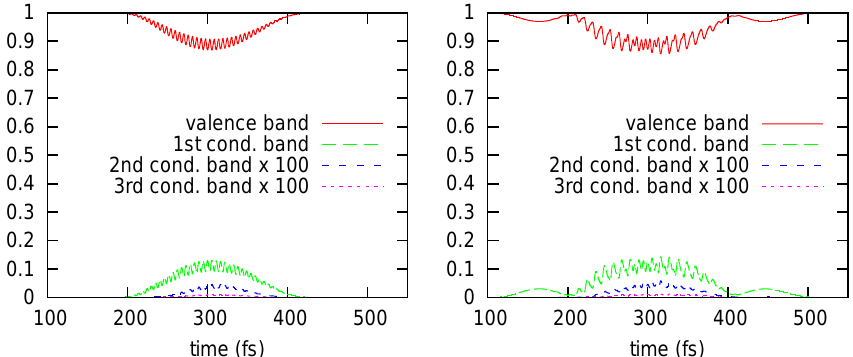
Figure 8. The normalized populations in the bands we considered as a function of time. The left subfigure corresponds to purely infrared excitation, while there is an additional long wavelength, THz field for the right subfigure. The corresponding waveforms can be seen in the insets of Figure 6.